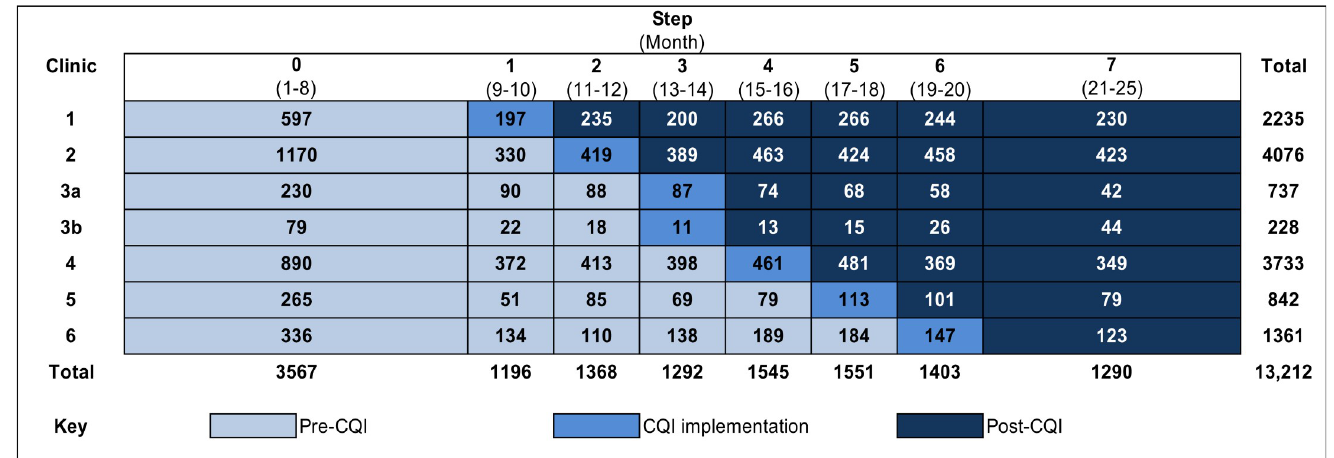
Fig 2. Study design and endpoint observations by actual randomisation sequence. Primary care clinics provided pre-intervention data until each rolled over to the CQI intervention in random order. All clinics provided data continuously throughout the study period. Baseline data collection across all clinics occurred from 15 July 2015 to 28 September 2015 (Step 0). As ANC data were captured retrospectively at delivery, the total observation period exceeded the data collection period by approximately 6 months. Width of each step is proportional to the number of months under observation. The baseline period (pre-intervention, depicted in light blue) contributed approximately 8 months, and the endline (Step 7) contributed approximately 4.5 months [30]. Intervention steps (intensive CQI phase, 2-month step) are depicted in medium blue. ANC, antenatal care; CQI, continuous quality improvement.